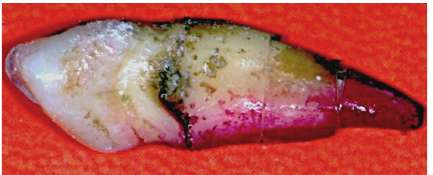
Figure 2: Joining the coronal, middle, and apical thirds with adhesive in order to prepare the